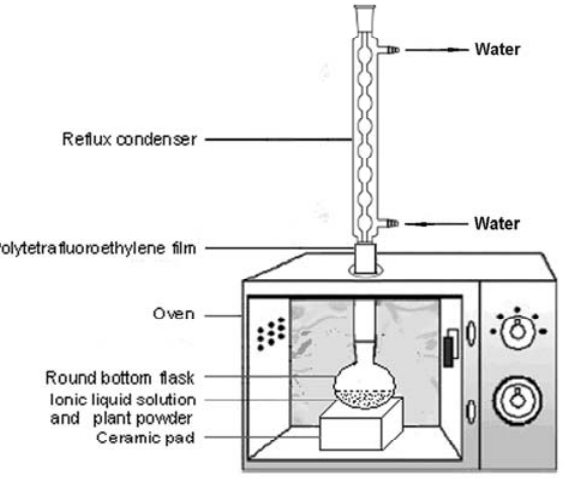
Figure 3. Schematic diagram of ionic liquids based microwave-assisted simultaneous extraction and hydrolysis